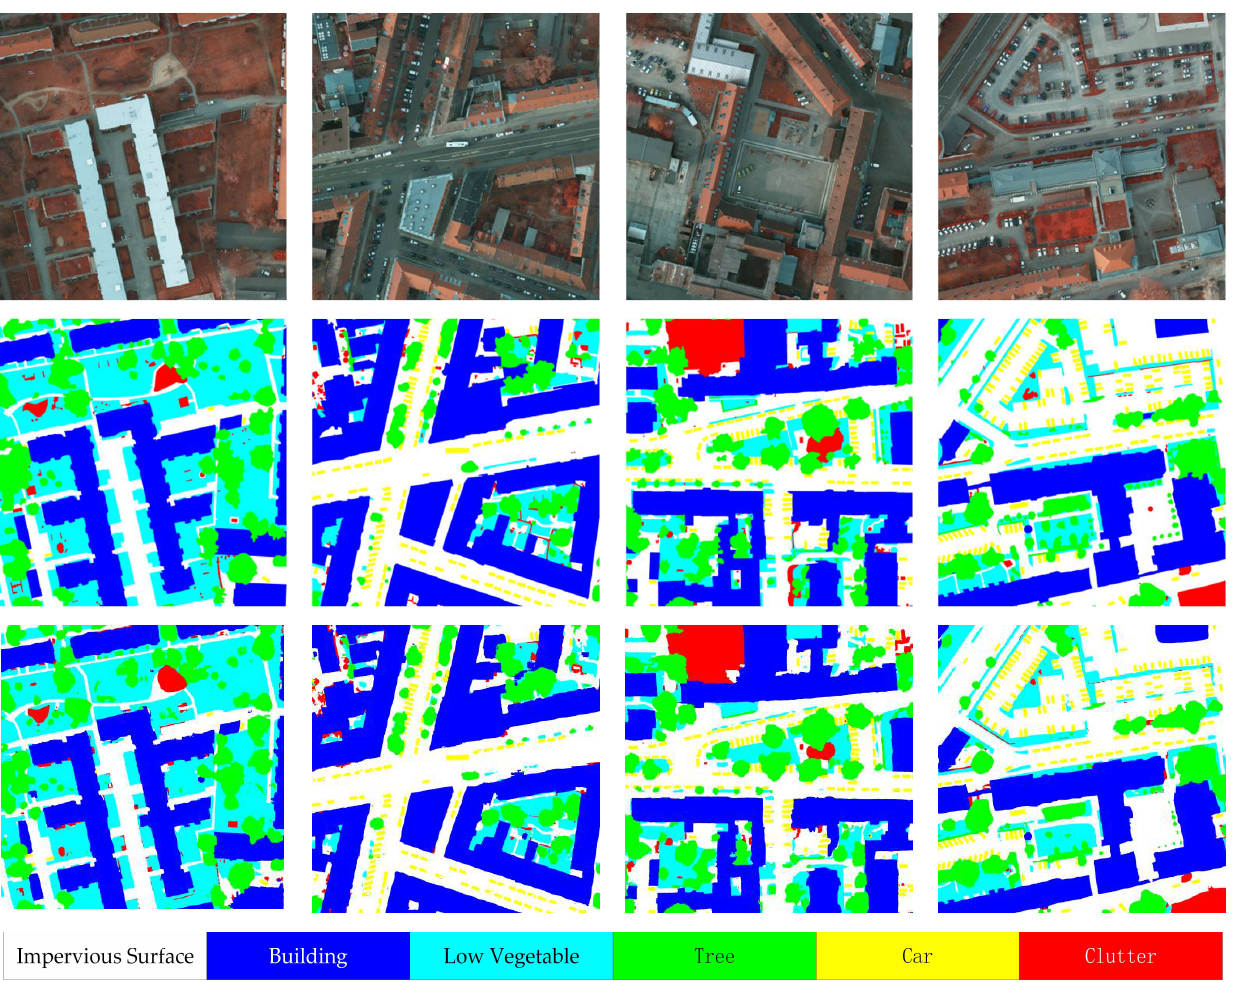
Figure 11. Results for large-scale images on the Postam dataset. From top to bottom: large-scale image, ground truth, and segmentation maps predicted by HA-MPPNet.